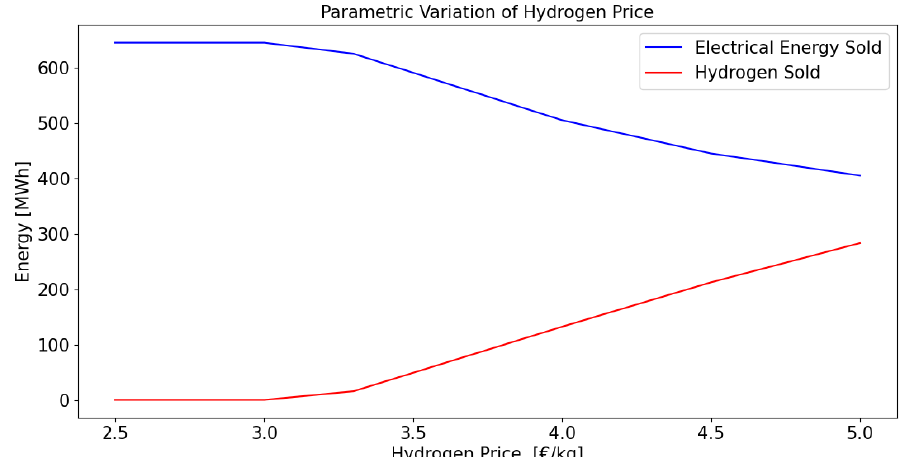
Figure 7. Daily energy sold under the form of hydrogen, in MWh, versus its unit price in e